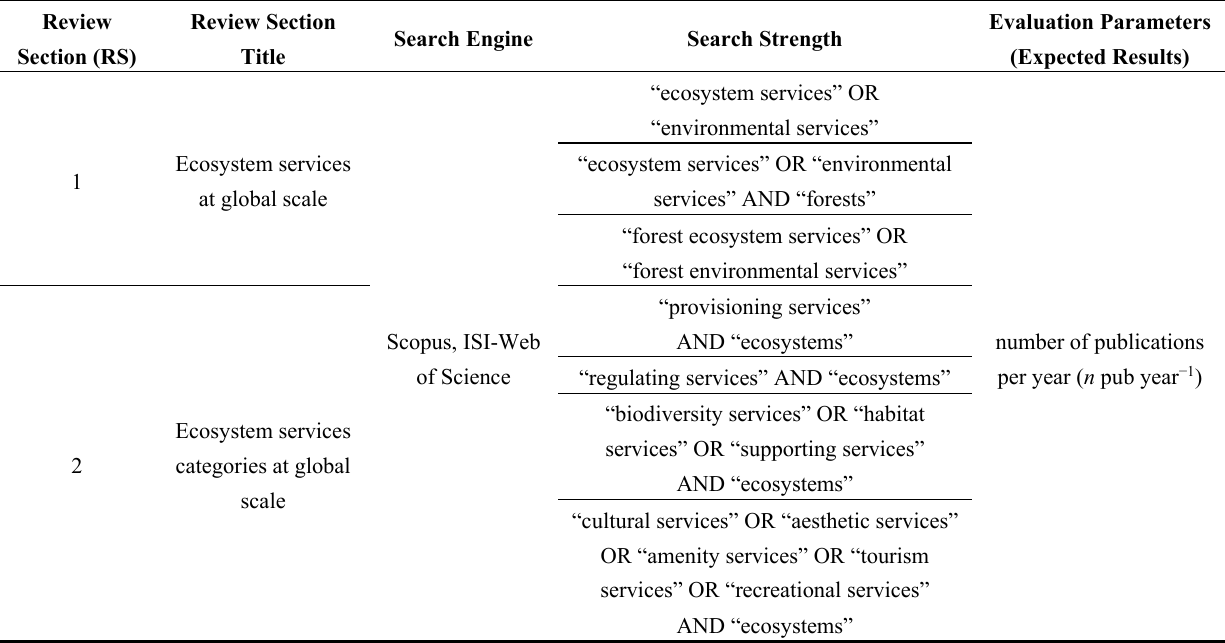
Table 1. Details on the procedure adopted for the literature